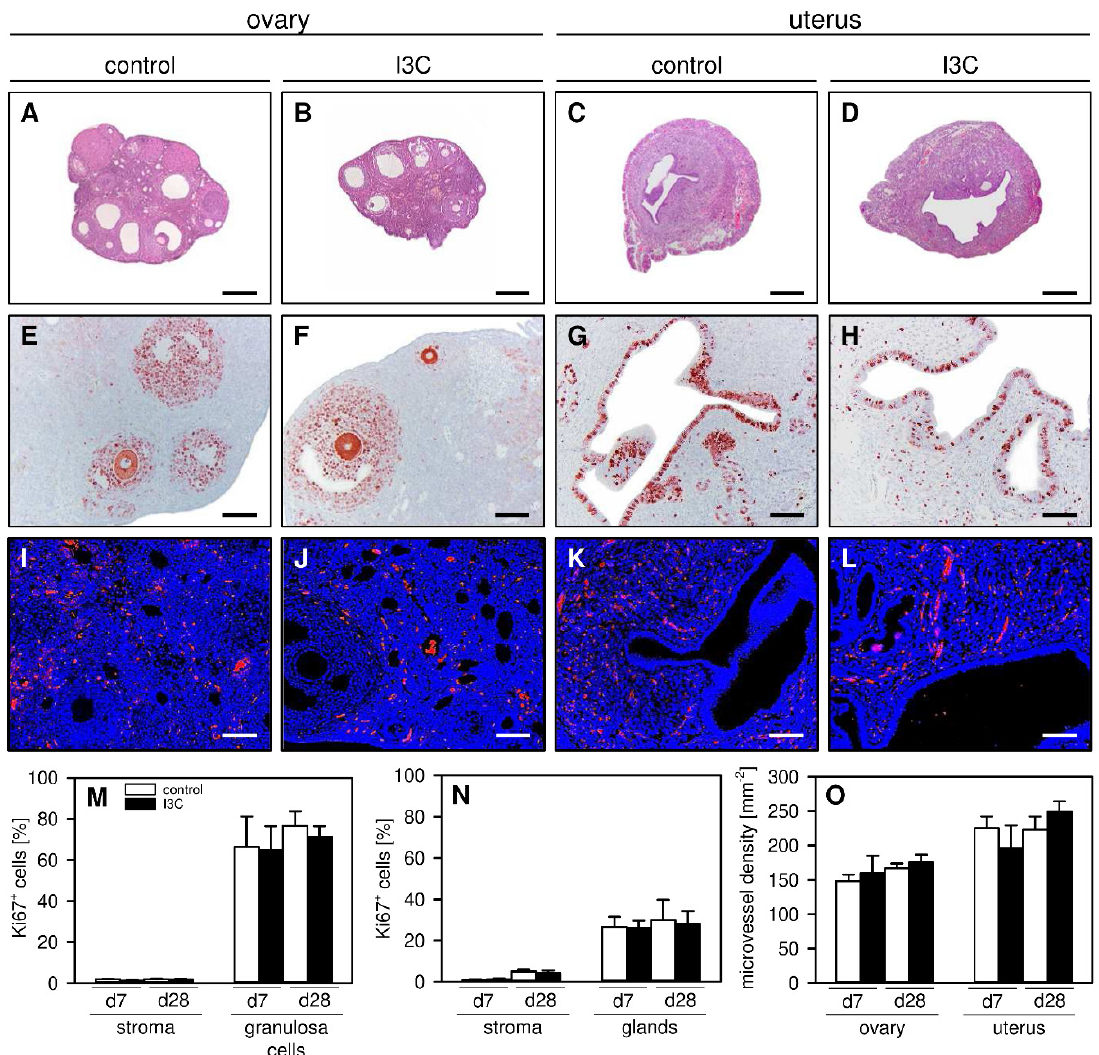
Figure 6. ( A - D ): HE-stained sections of the ovaries ( A , B ) and uterine horns ( C , D ) on day 28 after transplantation of uterine tissue samples to the abdominal wall of vehicle-treated control ( A , C ) and I3C-treated BALB/c mice ( B , D ). Scale bars: 270 µm. ( E – H ): Immunohistochemical detection of Ki67 + cells (red) in the ovaries ( E , F ) and uterine horns ( G , H ) on day 28 after transplantation of uterine tissue samples to the abdominal wall of vehicle-treated control ( E , G ) and I3C-treated BALB/c mice ( F , H ). Scale bars: ( E – H ) = 80 µm; ( I – L ) = 40 µm. ( I – L ): Immunofluorescent detection of microvessels in the ovaries ( I , J ) and uterine horns ( K , L ) on day 28 after transplantation of uterine tissue samples to the abdominal wall of vehicle‑treated control ( I , K ) and I3C‑treated BALB/c mice ( J , L ). The immunoflu‑ orescent sections were stained with Hoechst 33342 to identify cell nuclei (blue) and an antibody against CD31 for the detection of microvessels (red). ( M , N ): Ki67 + cells (%) within the stroma and treated control (white bars; n = 5–8) and I3C‑treated BALB/c mice (black bars; n = 6–8). Mean ± SEM. − 2 ( O ): Microvessel density (mm ) of the ovaries and uterine horns in vehicle‑treated control (white bars; n = 5–8) and I3C‑treated BALB/c mice (black bars; n = 6–8). Mean ±